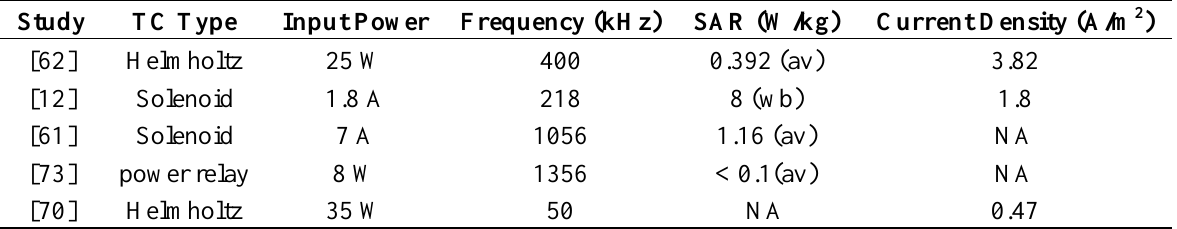
Table 7. Overview of biological tissue safety study for various WPT systems.